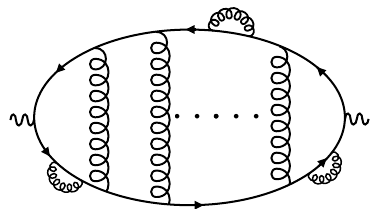
Figure 2 . Typical diagram contributing to the leading order calculation of the longitudinal con- ductivity.